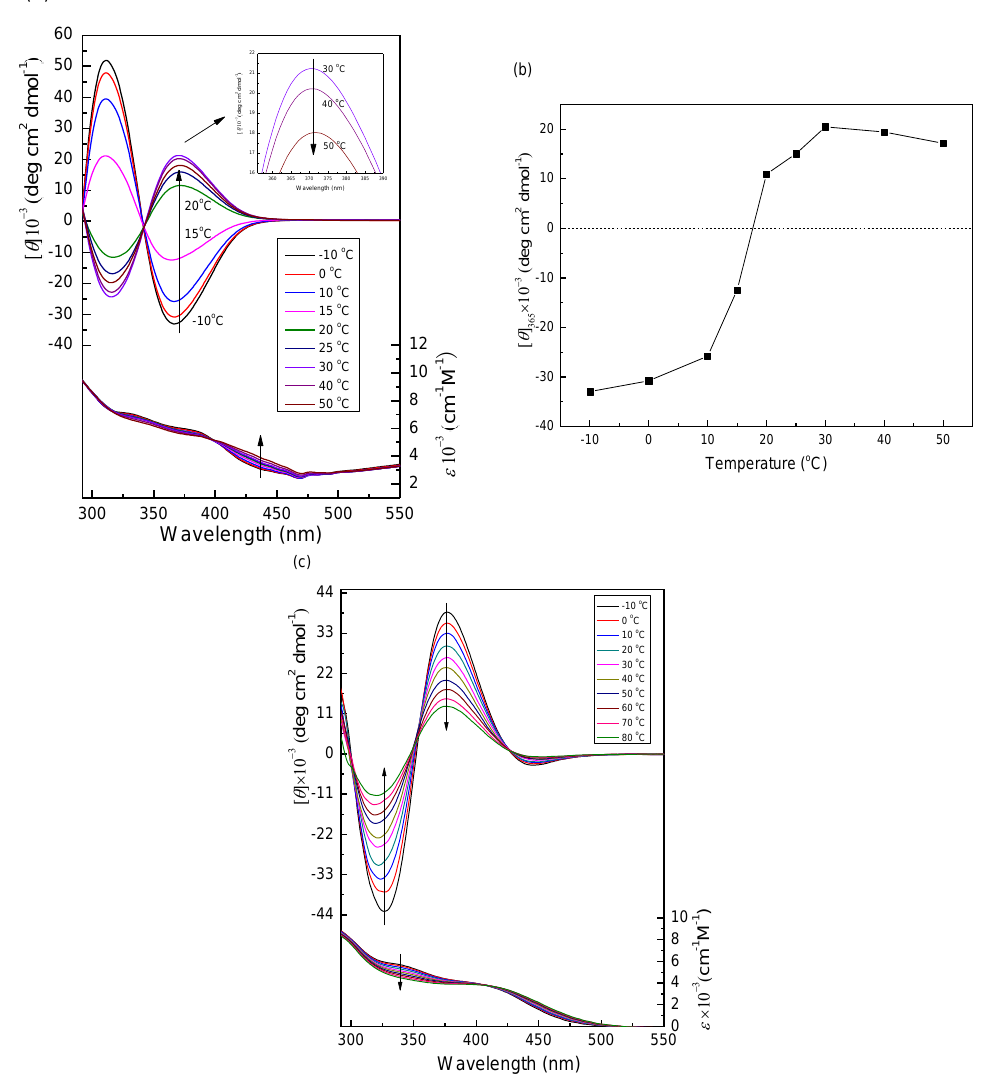
Figure 4. Temperature dependence of CD and UV-VIS spectra of PPAA-Val in CHCl 3 ( a ); plots of [ θ ] 365 of PPAA-Val in CHCl 3 versus temperature ( b ); and CD and UV-VIS spectra of PPAA-Val in DMF at different temperature ( c ) ( c = 1 mg/mL).